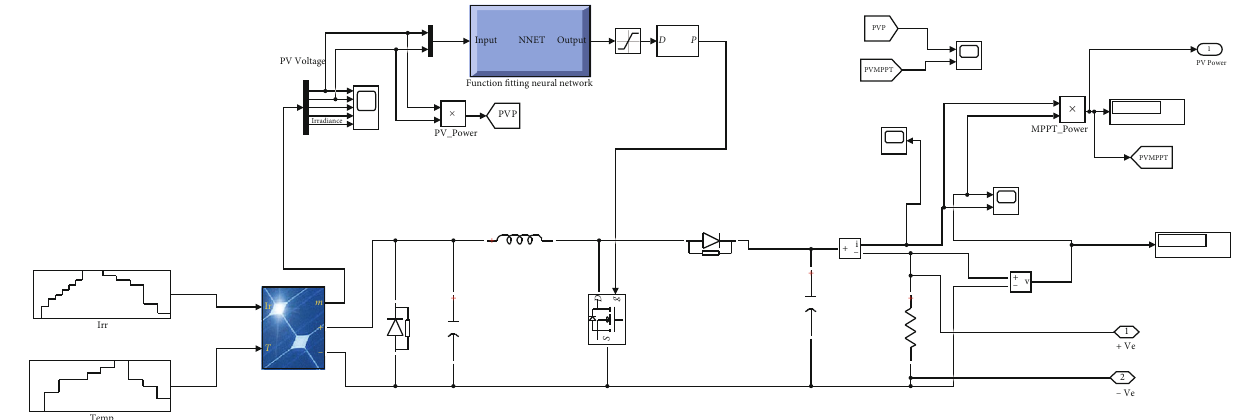
Figure 3: Simulation model of DNN-based MPPT algorithm for PV systems.